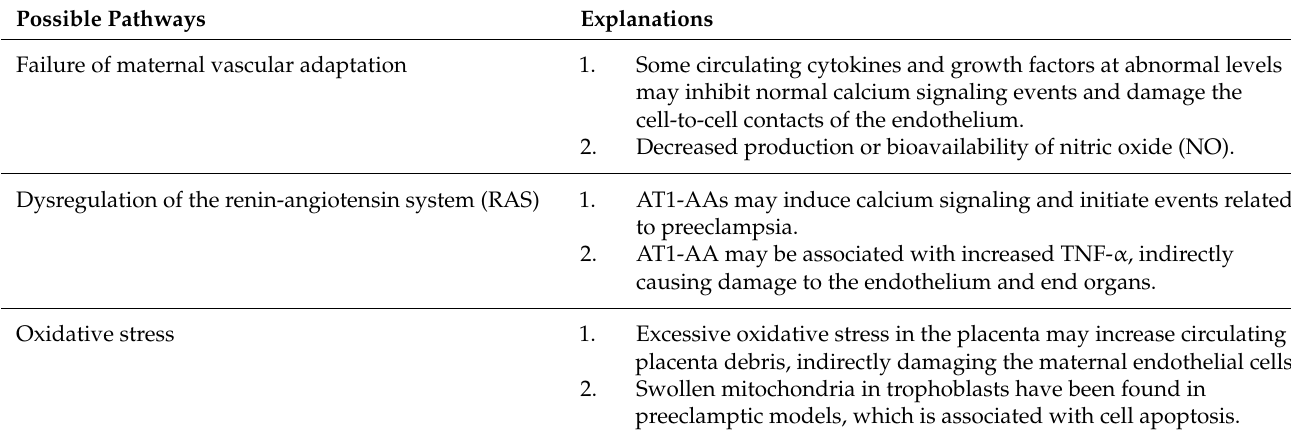
Table 4. Possible pathways and explanations of mechanisms underlying